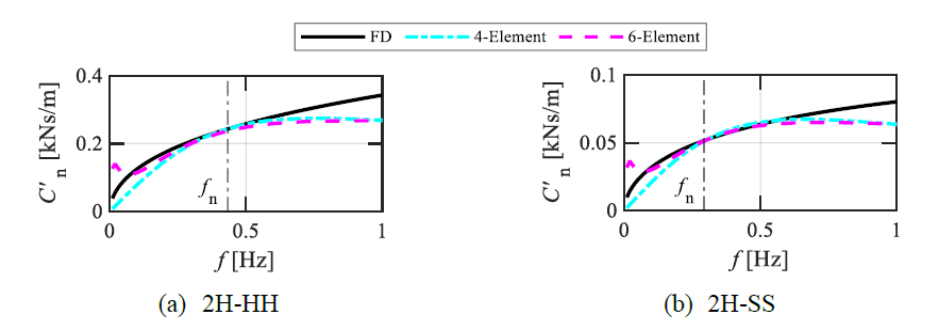
Figure A1. Effect of frequency sensitivity on the damping coefficient of VE